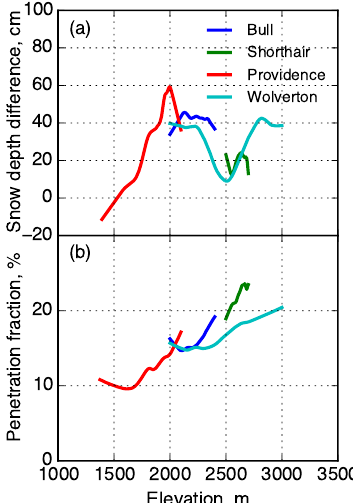
Figure 9. (a) Snow-depth difference along elevation for each site calculated from the LOESS-smoothed snow depth. (b) Average penetration fraction versus elevation for each